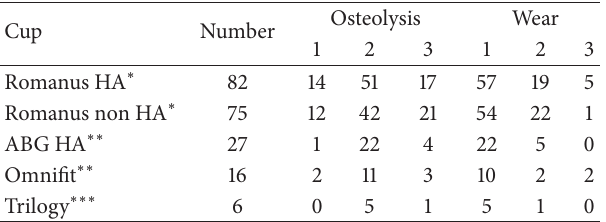
Table 3: Osteolysis and wear for each cup type. Osteolysis classified according to the system presented in the text. Wear presented